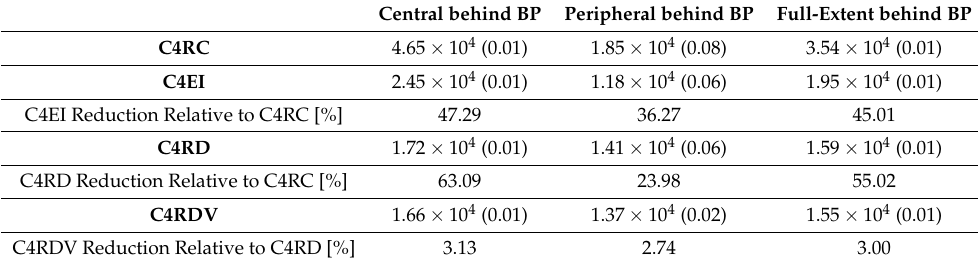
Table 1. Total neutron flux [n/cm 2 /s] (MCNP relative error) in BP tallies. Central behind BP Peripheral behind BP Full-Extent behind